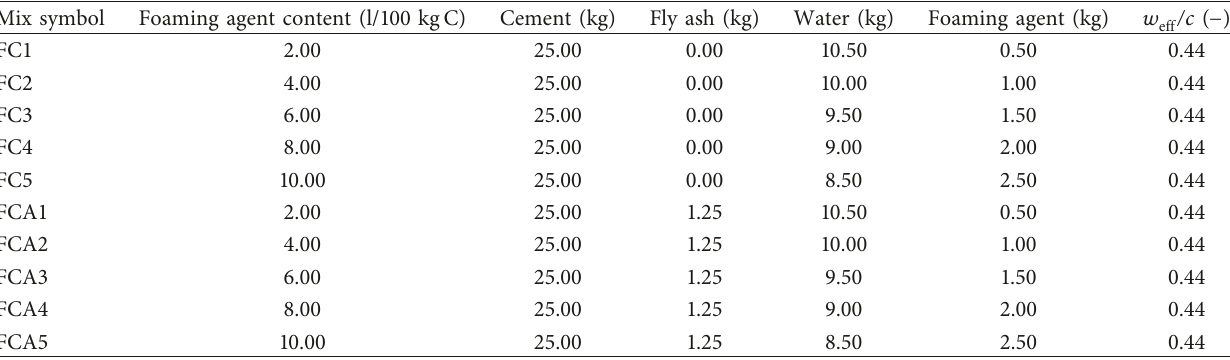
Table 1: Mix proportions.